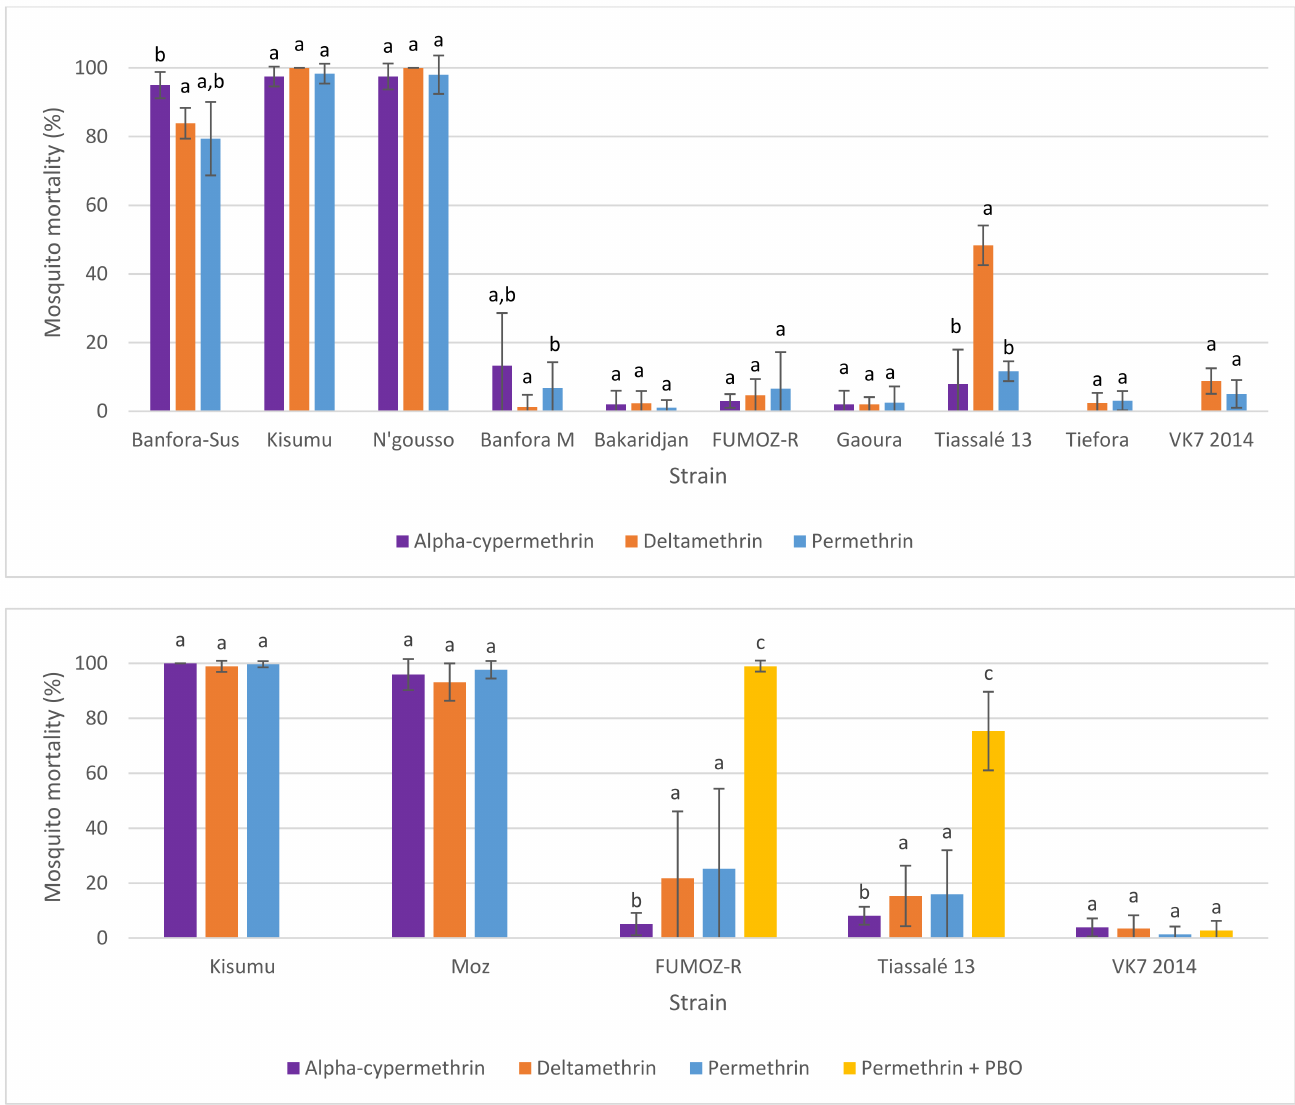
Figure 7. Average mosquito mortality following exposure to α -cypermethrin 0.05% (purple), deltamethrin 0.05% (orange), permethrin 0.75% (blue), or permethrin 0.75% preceded by piperonyl butoxide (PBO) (yellow) in a standard WHO tube bioassay in LSTM ( top ) or LITE ( bottom ) strains. Bars sharing the same superscript letter were not significantly different ( p < 0.05, Welch’s t -test). Error bars show the standard deviation to indicate variability between replicates. The p -values are shown in Supplementary Material, Table